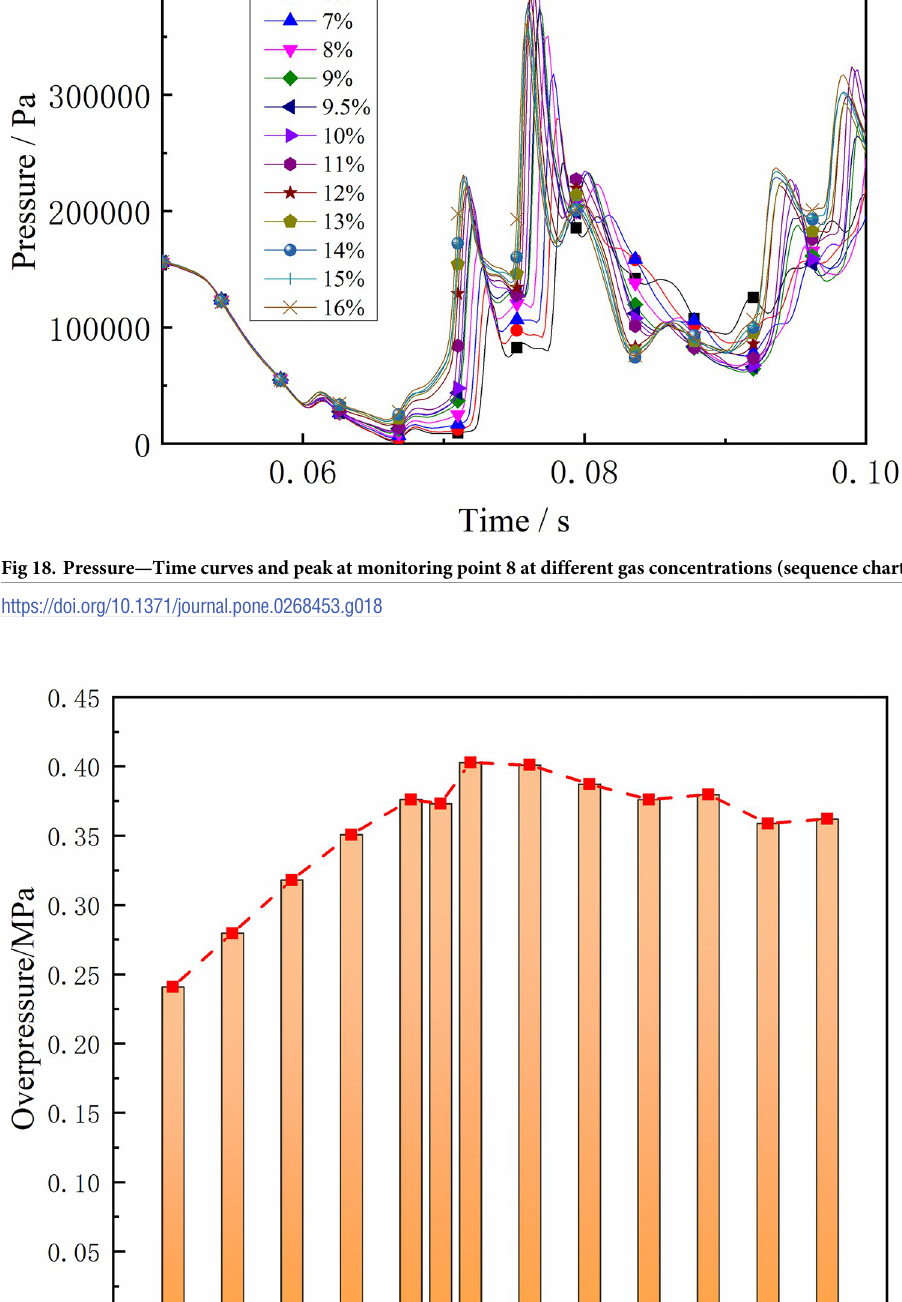
PLOS ONE | https://doi.org/10.1371/journal.pone.0268453 May 26,